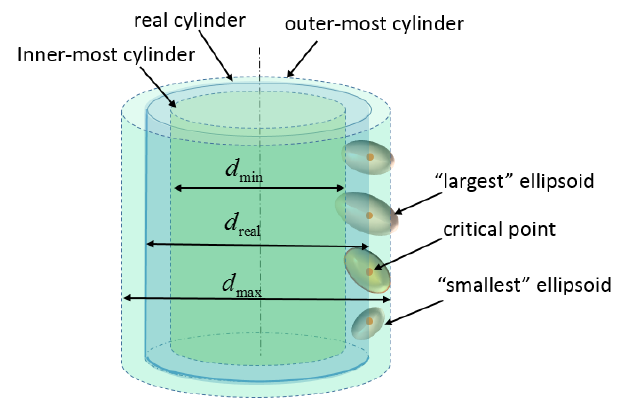
Figure 5. Critical point on a cylinder surface.